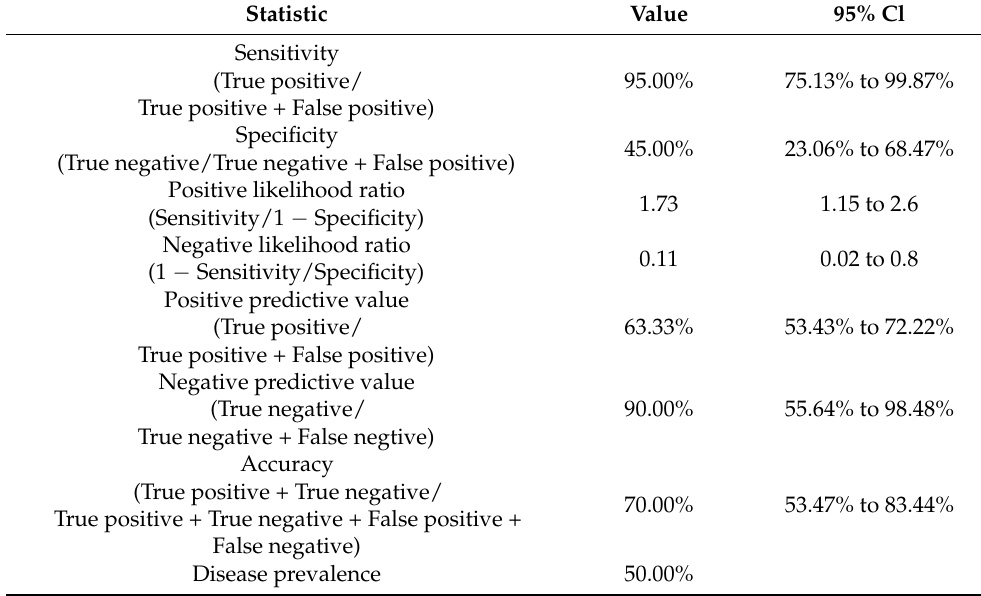
Table 3. The statistical relationship between the results of the dot blot assay of clinical plaque samples compared with clinical